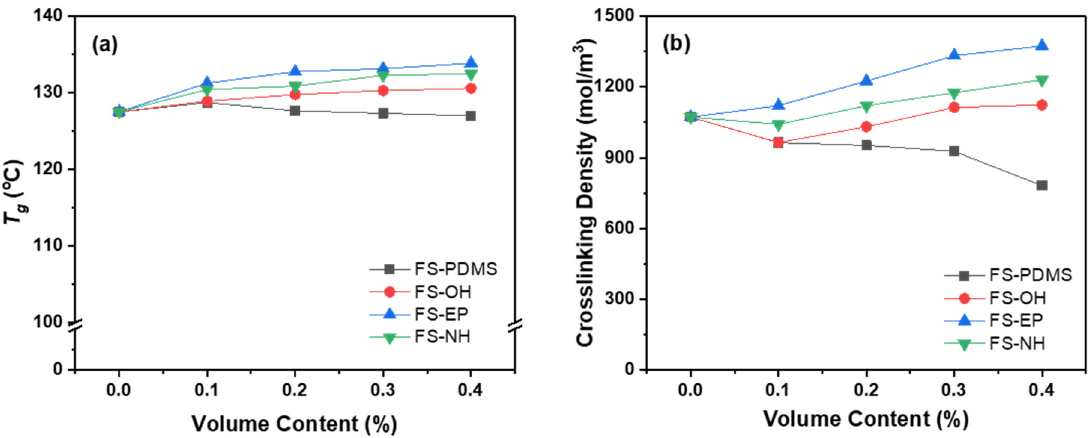
Figure 5. Dynamic mechanical analyser (DMA) measurement results by contents of silica nanoparticles: ( a ) glass transition temperature, and ( b ) crosslinking density.